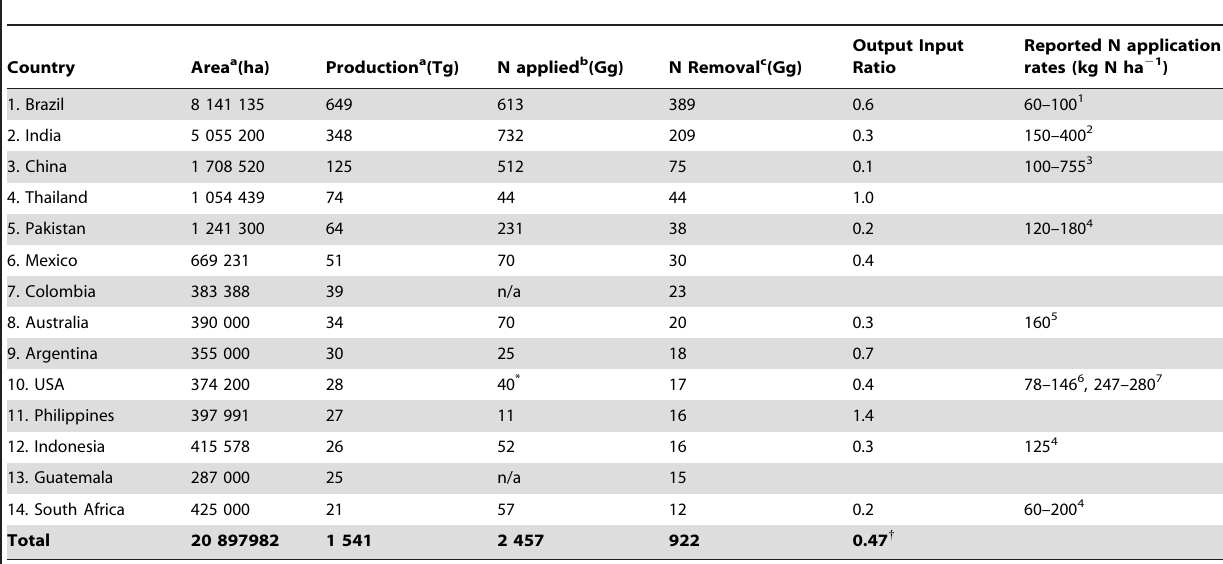
Table 1. Sugarcane production and N fertilizer application of the top 14 sugarcane producing countries, which account for 86 and 88% of global sugarcane production area and cane yield, respectively.